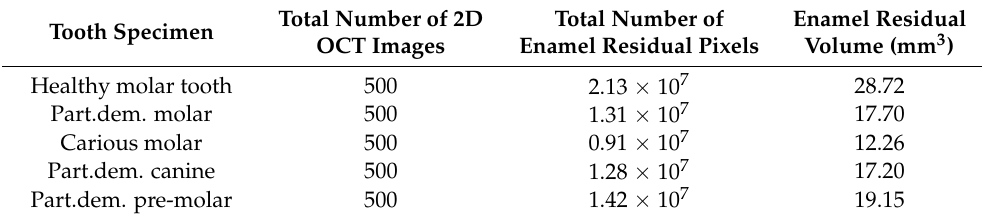
Table 4. The volumetric evaluation results of the enamel